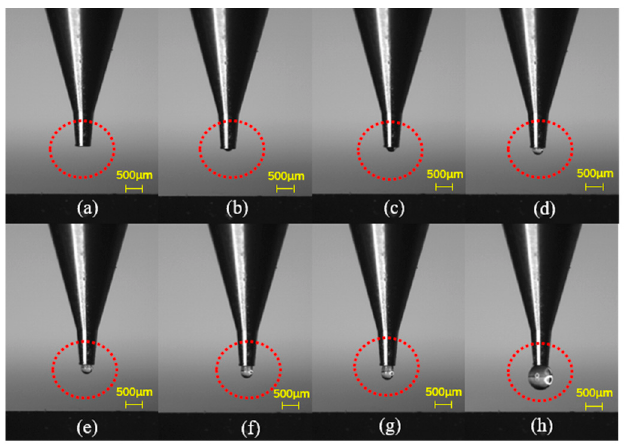
Figure 3. Extruding process of the fused PCL material under air pressures.( a – d ) the forming pro- cess the shape of the meniscus; ( e – h ) the process of changing from the shape of the meniscus to a round